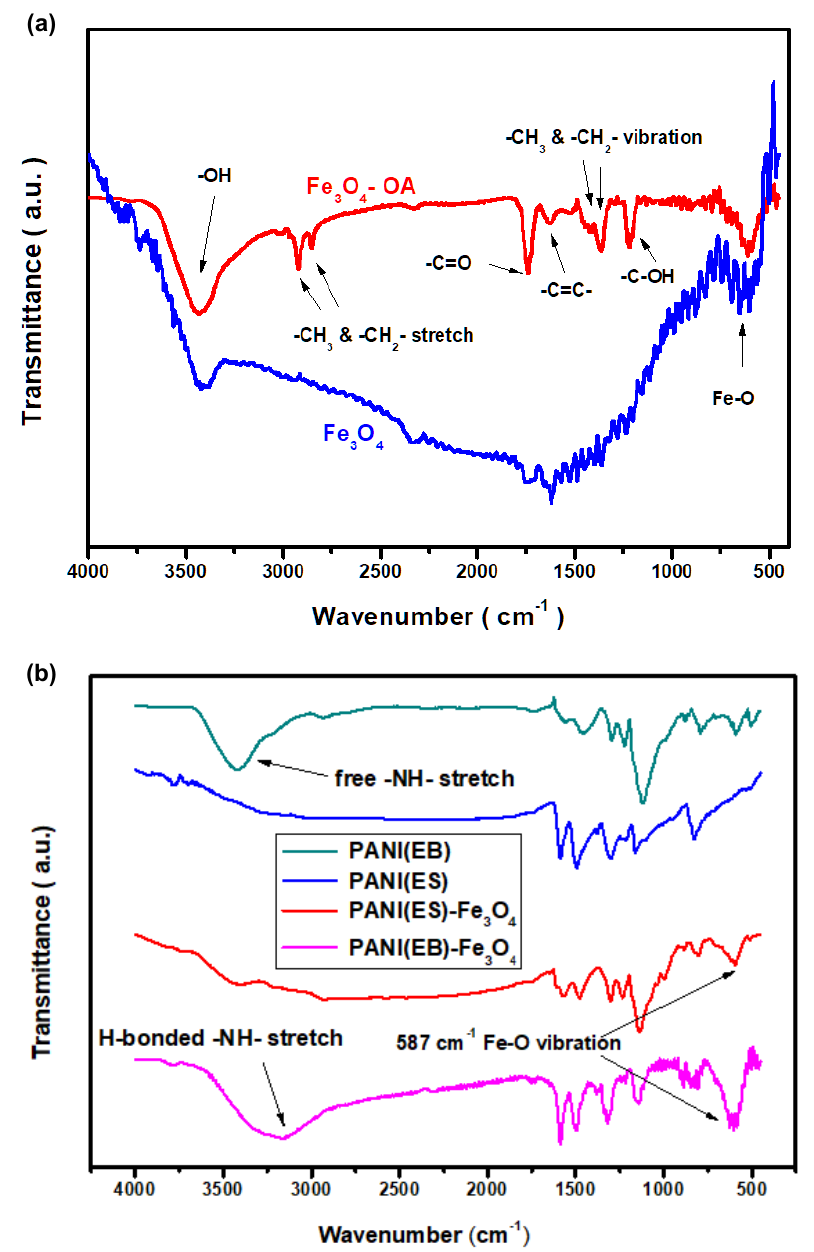
Figure 1. FTIR spectra of ( a ) Fe 3 O 4 and Fe 3 O 4 (OA) ( b ) PANI and PANI/Fe 3 O 4 .